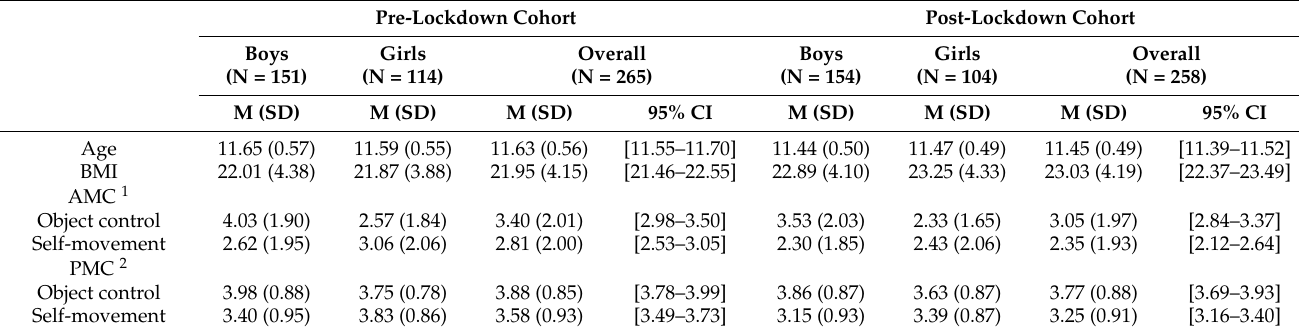
Table 1. Descriptive statistics of the characteristics of the cohorts and the AMC and PMC in their dimensions of object control and self-movement.